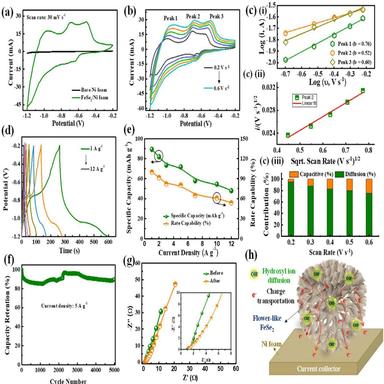
Electrochemical properties of the FS nanostructure as a SC electrode measured in aqueous alkaline electrolyte at room temperature. (a) Comparative CV curves of the pristine Ni foam and FS nanostructure coated Ni foam electrode measured at a constant scan rate of 0.3 V s−1 and (b) CV curves measured at various scan rates of 0.2–0.6 V s−1. (c)(i) logarithm relationshis for b values, c(ii) plots of v1/2 vs. i/v1/2 used for identifying the constants of S1 and S2 peak 2 currents from the CV curves and (c)(iii) c